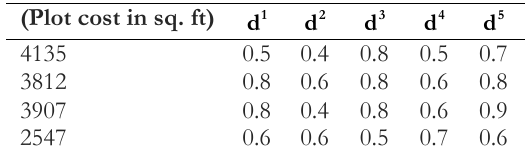
Table 3. Decision making fuzzy values for the cost of the